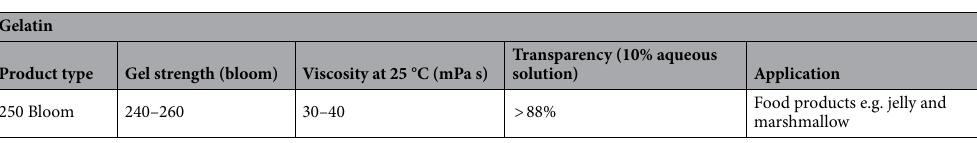
Table 1. Properties of gelatin.